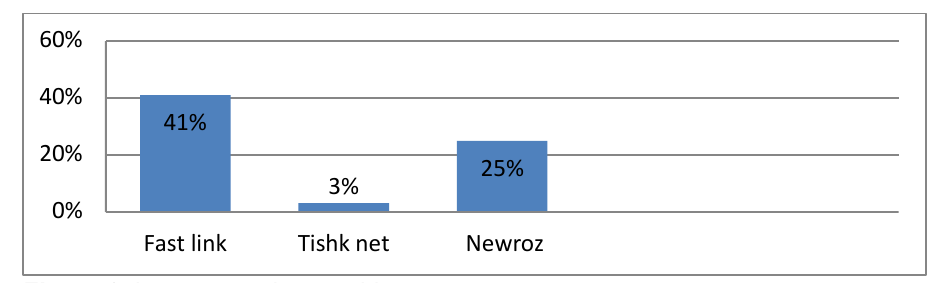
Figure 9 : internet service